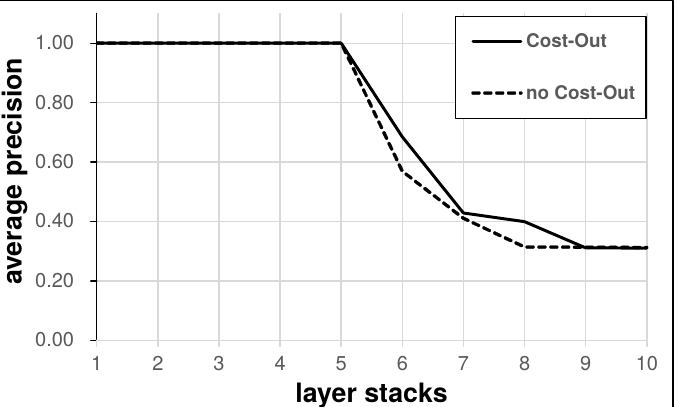
Figure 6. Best precision averaged over five models by the number of stacked layers with or without Cost-Out in TDC-disjoint